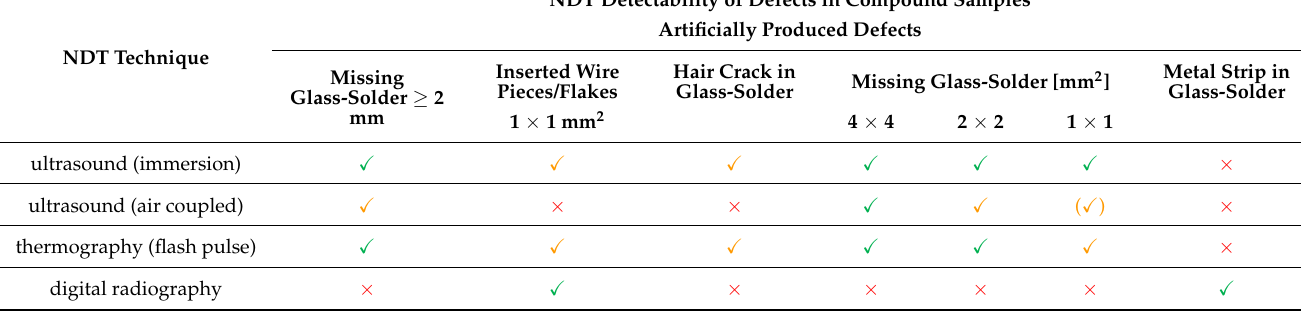
Table 1. Detection of artificial defects in cell elements.